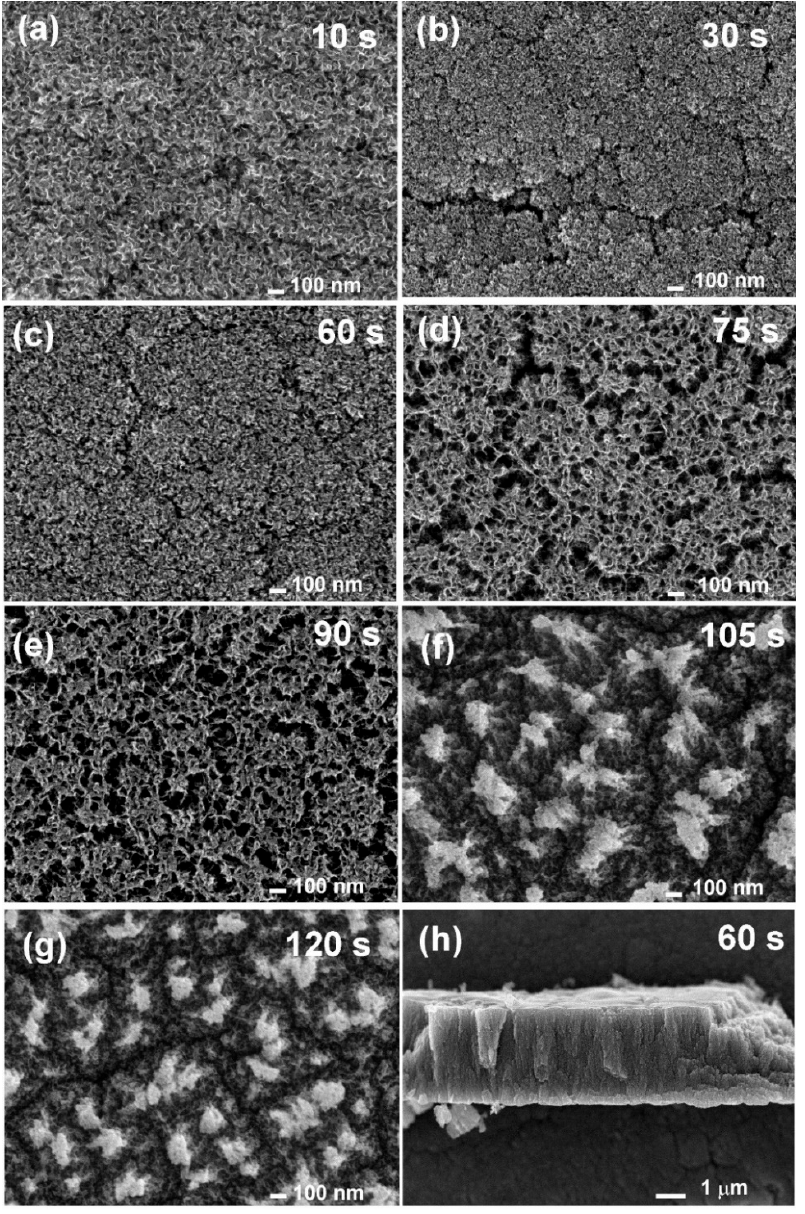
Figure 3. ( a – g ) Scanning electron microscopy (SEM) images of N-doped carbon nanomesh deposited at various deposition times, and ( h ) cross-section of the deposited formed at 60 s of